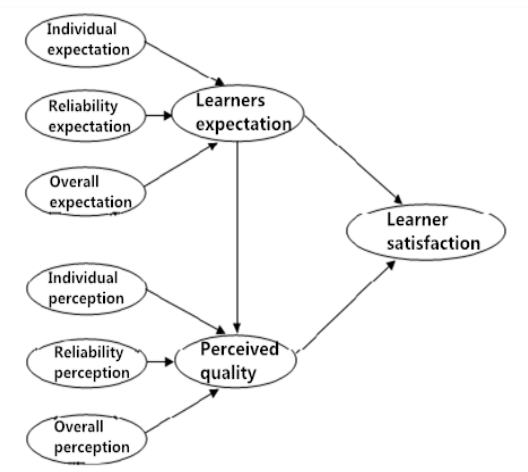
Figure 2: Evaluation model of network learning resources based on user